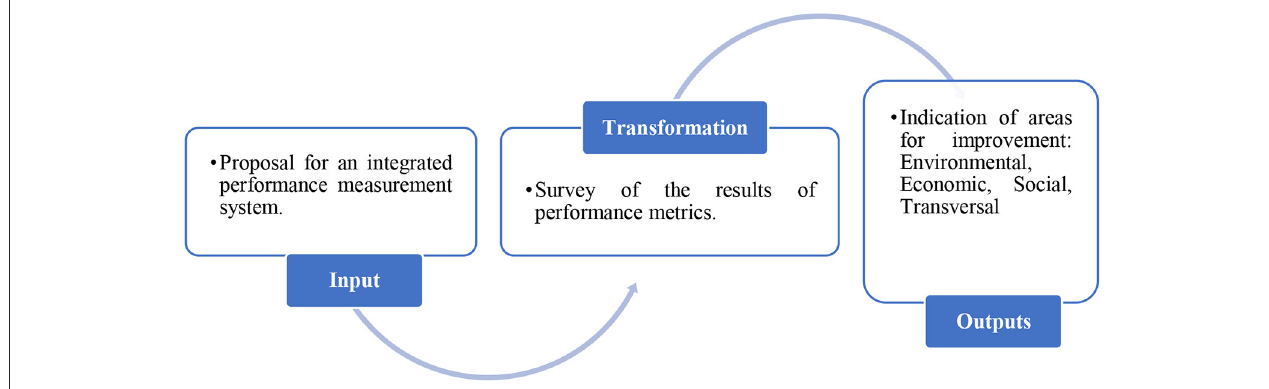
FIGURE 5 | Proposal for an integrated performance measurement system. Source: Adapted de Almeida Santos et al.